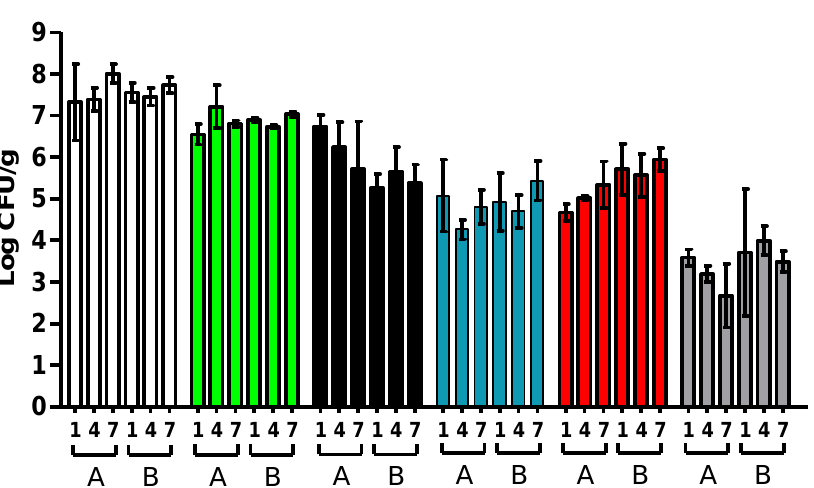
Figure 3. Microbial counts (Log CFU/g) at the time of spoilage of hake fillets stored in MAP of the two batches studied (A and B) and at each of the temperatures investigated (1, 4, and 7 °C). Anaerobic psychrotrophs (white bars), Photobacterium (green bars), Shewanella (black bars), Pseudomonas (blue bars), Lactic acid bacteria (red bars) and Enterobacteriaceae (grey bars). Error bars represent the standard deviation.